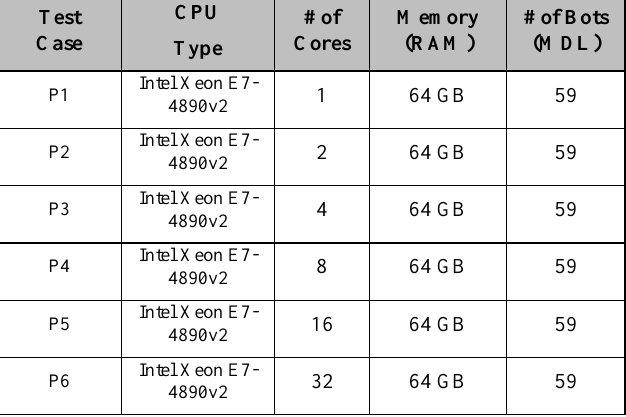
Table 3: Phase 2 Prototype Hardware and Bot